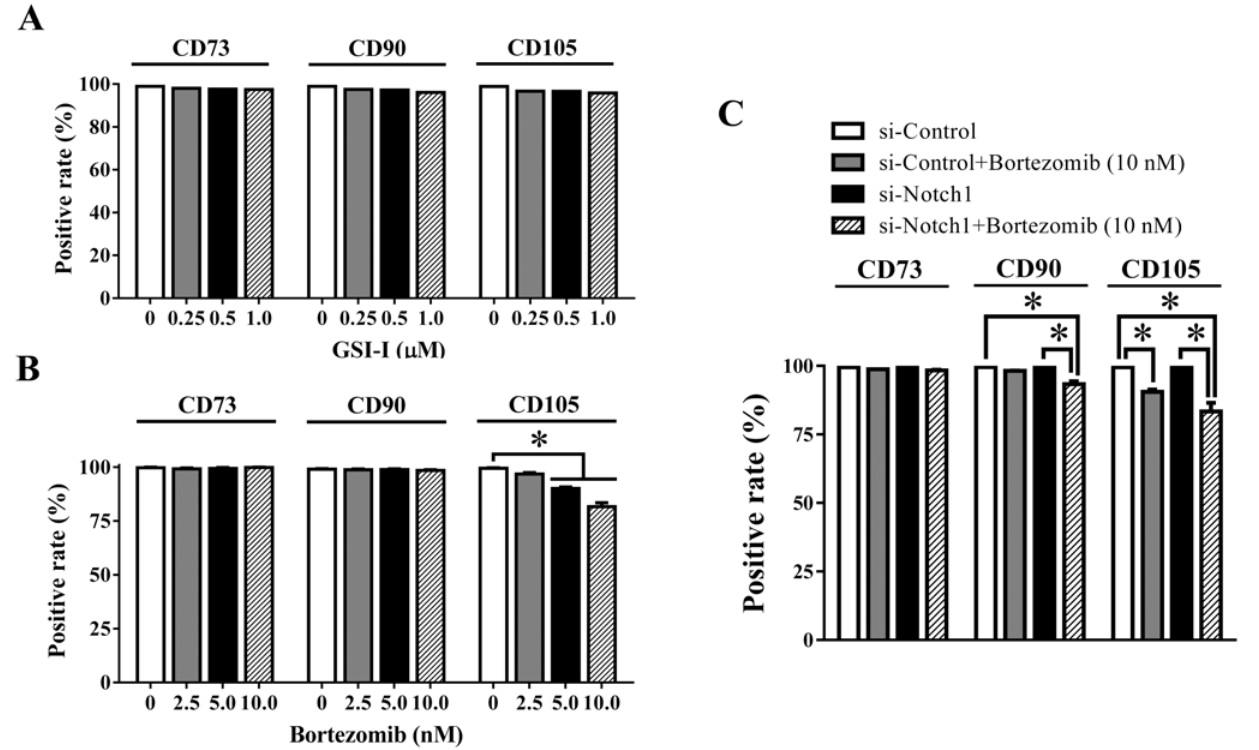
Fig 6. Both Notch signaling and proteasome pathway are involved in regulating CD105 expression in hUC-MSCs. Flow cytometry assay shows that 0.25 – 1 μ M GSI-I do not induce changes in expression of CD73, CD90 and CD105 (A), but 5 – 10nM Bortezomib significantly inhibits the expression of CD105, but not CD73 and CD90 (B); Moreover, while the siNotch1 transfection alone has no effect on expression of surface markers, it further increases the inhibitory effect of 10 nM Bortezomib on CD105, slightly on CD90, but not on CD73 (C). The * indicates the statistical significance with p <